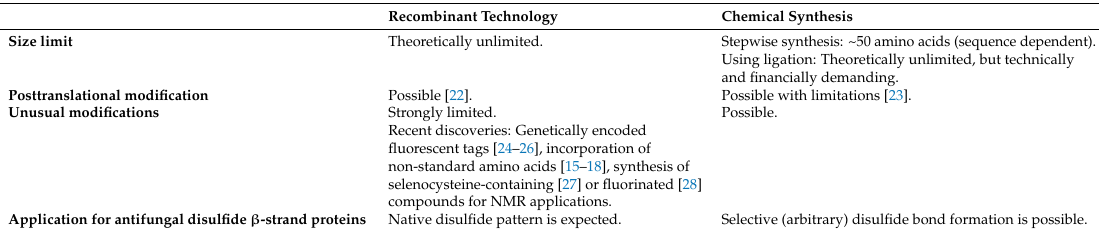
Table 2. Possibilities of protein production by biotechnology and chemical synthesis.